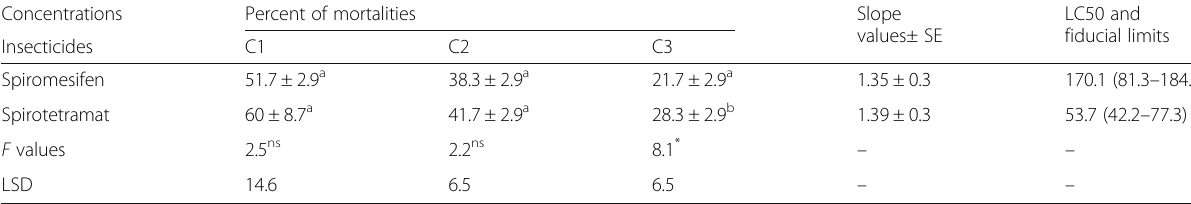
Table 1 Toxicity of spiromesifen and spirotetramat on second instar larvae of cotton leaf worm, S . littoralis Concentrations Percent of